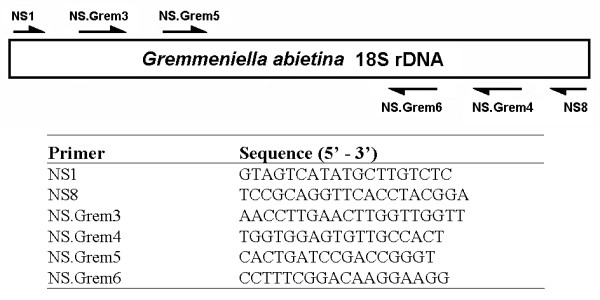
Location and sequences of the primers used in this study.